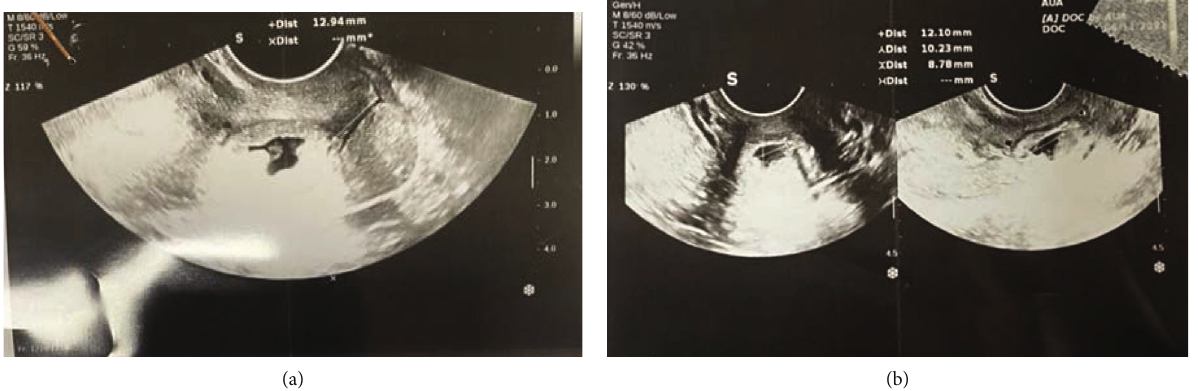
Figure 2: The 2 nd ultrasonography, a fetal echo (with FHR +) in the pregnancy